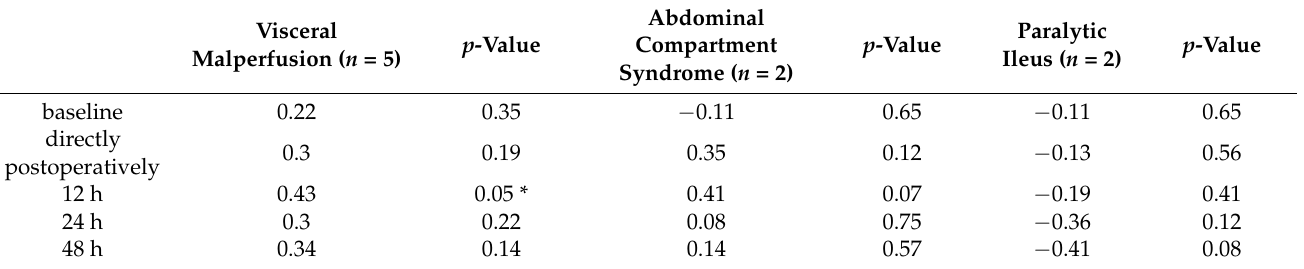
Figure 2. Heat-shock protein 70 (HSP70) serum levels at different time points for the two groups: abdominal complications ( n = 9) and no abdominal complications ( n = 12). Bar represents the median, and the whiskers represent the interquartile range. Significance is annotated above the brackets as (*) for p < 0.05 and (**) for p < 0.01. Table 4. Spearman’s correlation for heat-shock protein 70 serum levels and the abdominal compli- cations subgroups. Correlation presented with Spearman’s (rho). Significance marked with (*) for p <